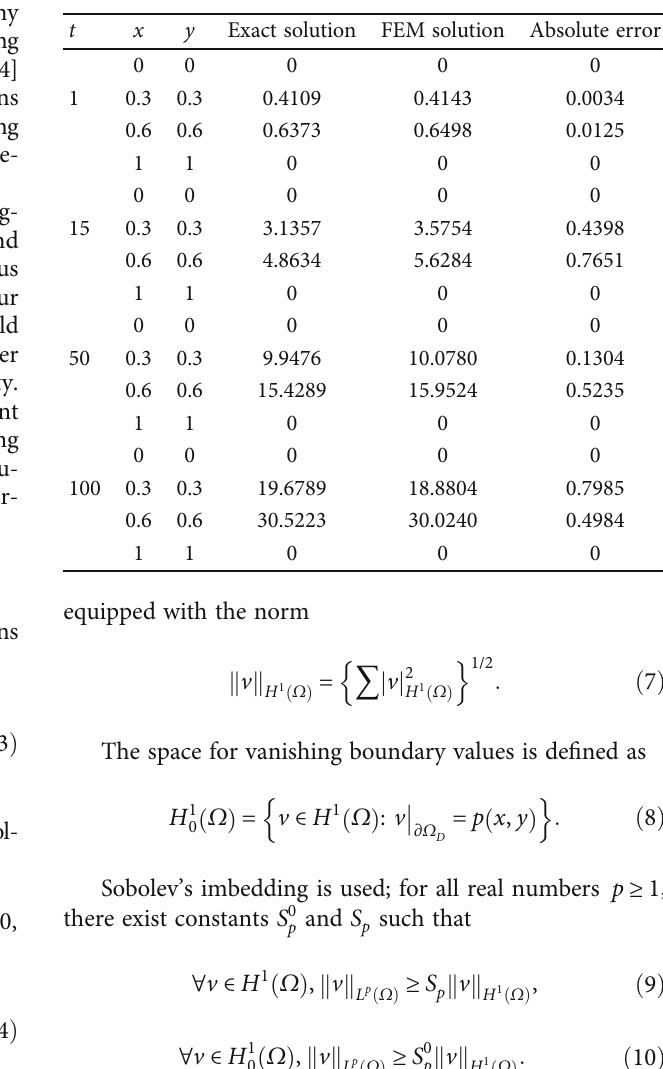
Table 1: Comparison of the exact and the numerical